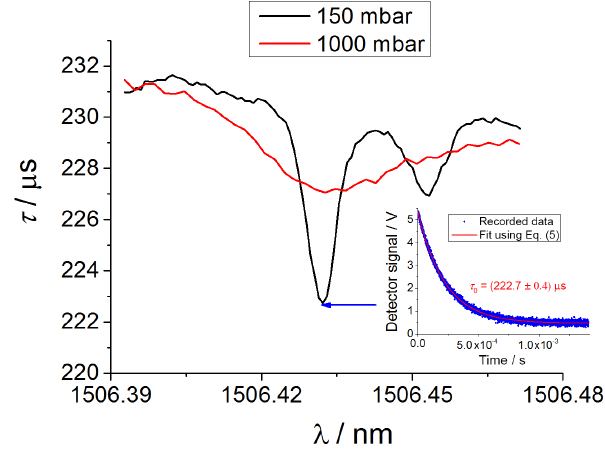
Figure 3. Typical laser scans of the ring-down time, τ , as a function of wavelength, recorded for a HIRAC pressure of 150mbar (black line) and 1000mbar (red line) mixture of N 2 : O 2 = 4 : 1 and 295K. For the sake of clarity the measure- ment at 1000mbar was rescaled by adding 18µs to τ . HO 2 radicals were generated in the chamber using CH 3 OH / Cl 2 / O 2 and black lamps: [CH 3 OH] 0 = 7 × 10 13 moleculecm − 3 and [Cl 2 ] 0 = 4 × 10 13 moleculecm − 3 in the experiment at 150mbar and [CH 3 OH] 0 = 2 × 10 14 moleculecm − 3 and [Cl 2 ] 0 = 2 × 10 14 moleculecm − 3 in the experiment at 1000mbar. The number of ring-down events averaged at each wavelength and the laser wavelength step were 50 events and 8 × 10 − 4 nm (150mbar) and 25 events and 2 × 10 − 3 nm (1000mbar). The inset shows the ring-down trace acquired at 1506.43nm and 150mbar and the fit by Eq. (5) to extract τ = (222.7 ±